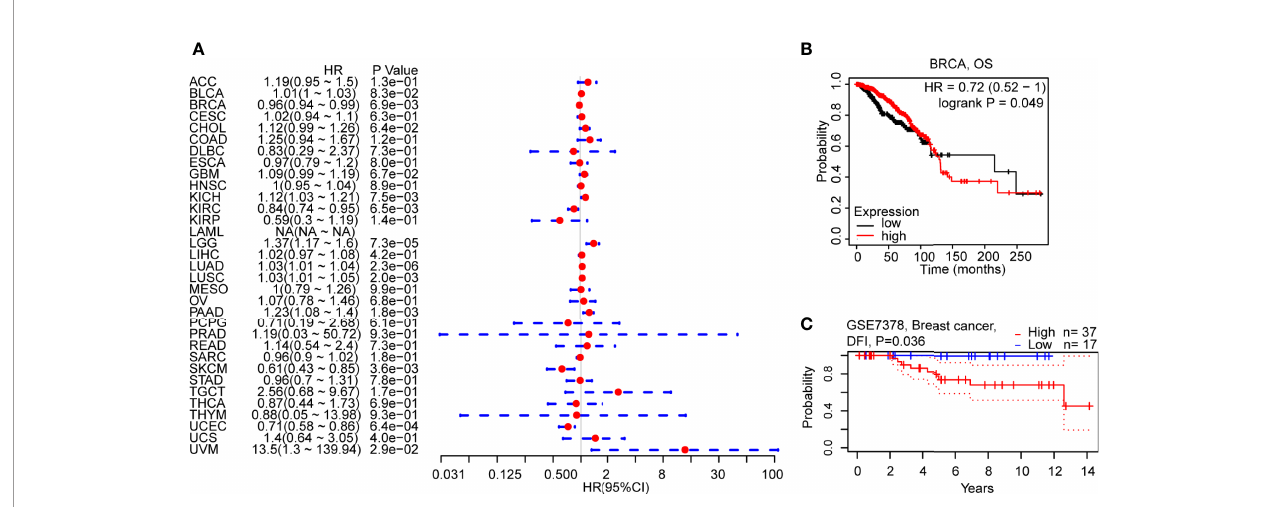
FIGURE 2 | Correlations of C5AR2 expression with patient prognosis. (A) Forest plot of correlations between C5aR2 expression level and DSS across diverse tumors in TCGA database. (B) Survival curve of OS in BRCA in Kaplan-Meier plotter database. (C) Survival curve in the cohorts of GSE7378 in PrognoScan